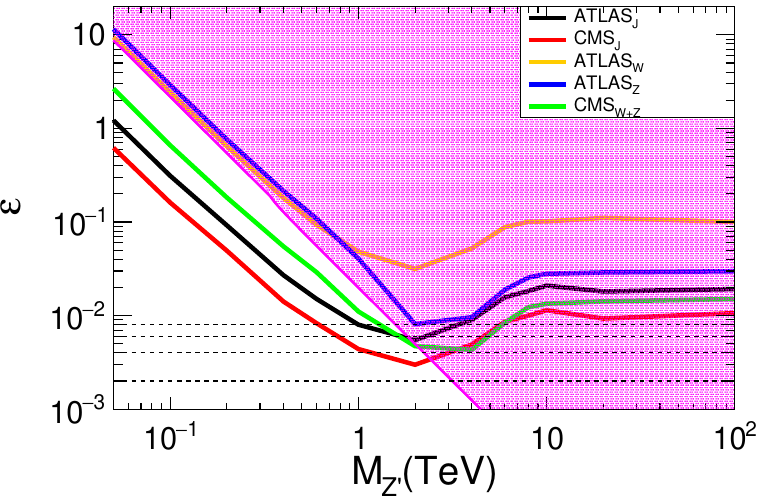
Figure 3. 95% CLs upper limit on NSIs in a simplified Z 0 model as a function of the mass of Z 0 with various measurements at the LHC. We assume (cid:15) u = (cid:15) d = (cid:15) and Γ Z 0 /M Z 0 = 0 . 1 .